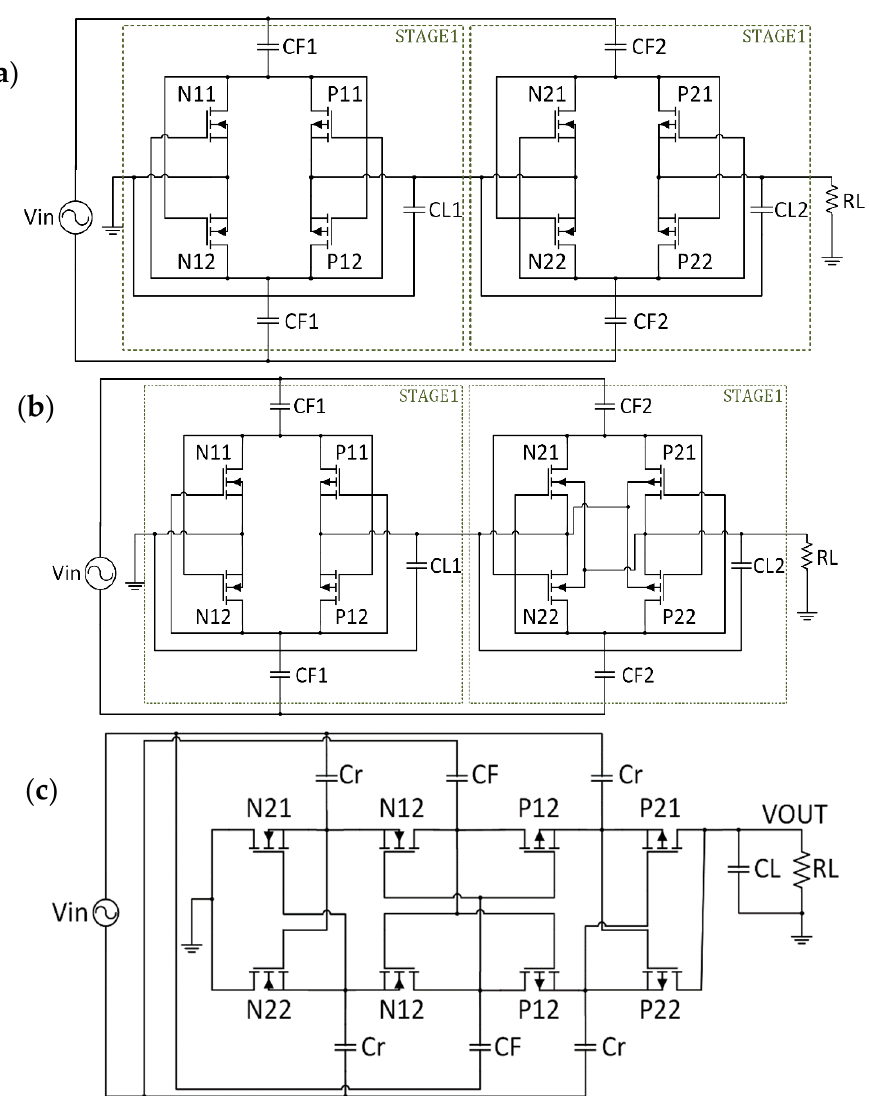
Figure 3. Different CCDD-based topologies used in this work: ( a ) conventional CCDD or CDC (only TFET), ( b ) conventional/body bias or CDB (only for 32 nm), and ( c ) bias control by level shift or CDC (32 nm and TFET). Note that CDN is not a cascaded configuration as in the topology CDC and CDB.